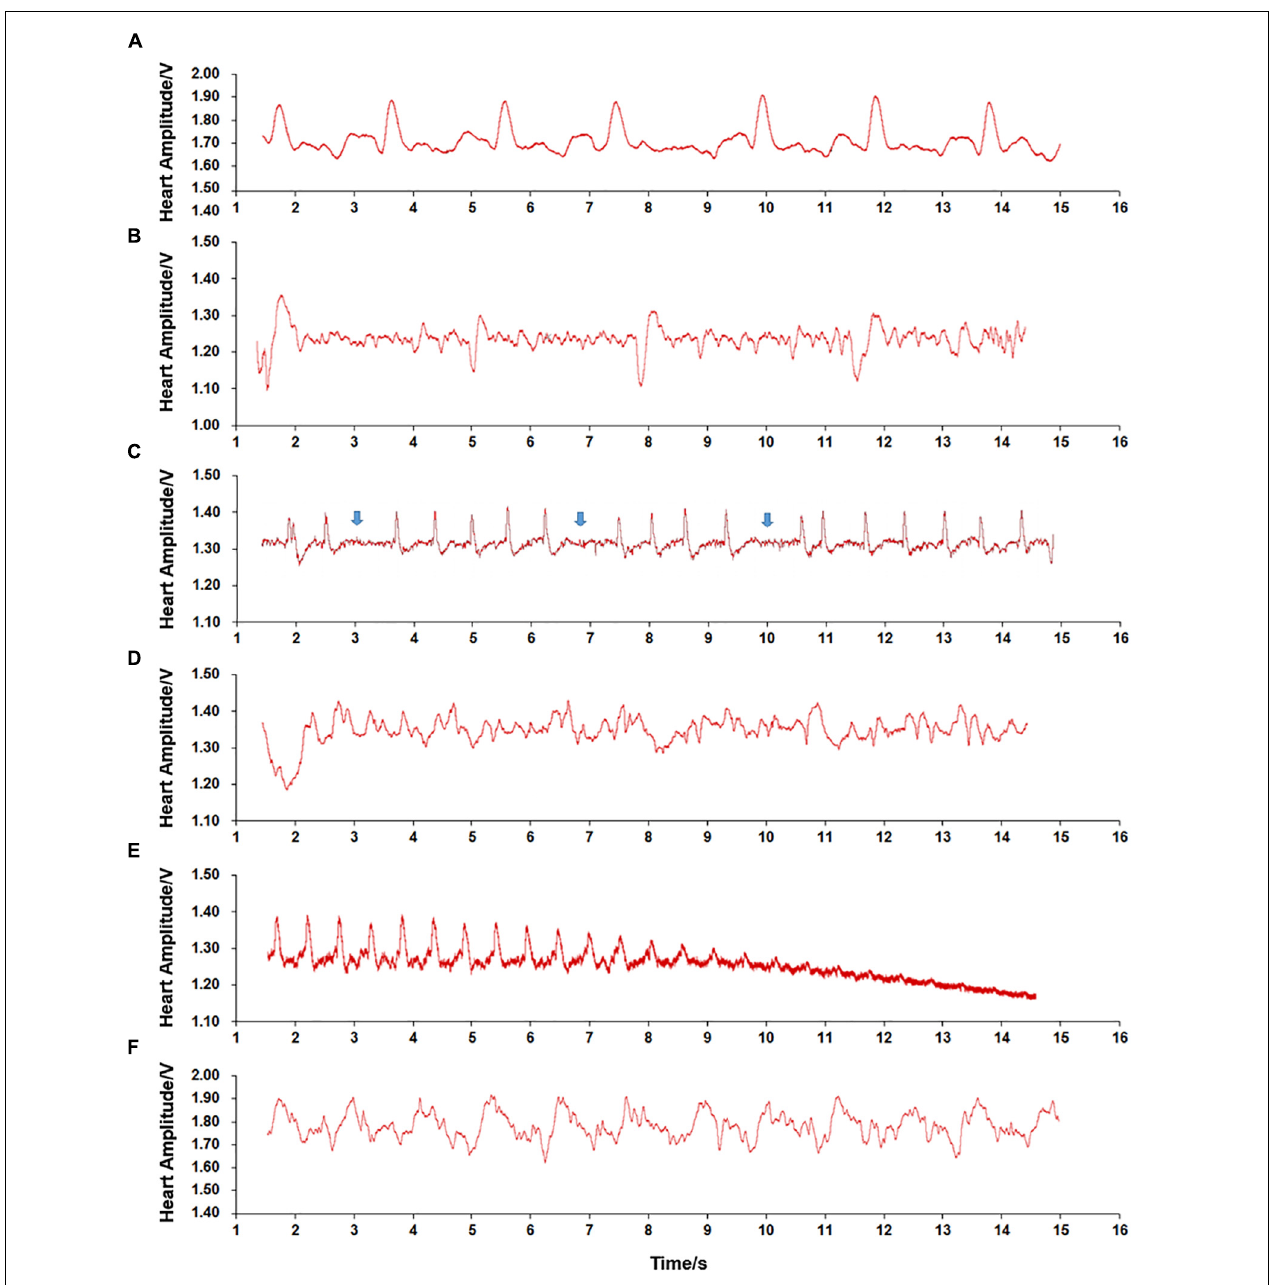
FIGURE 4 | Plethysmograms of cardiac performance recorded during temperature challenge. (A) Regular signal pattern recorded in scallops submerged in 15 ◦ C seawater. (B) Bradycardia recorded in scallops submerged at low temperature (5 ◦ C). (C) Temporary cardiac arrest recorded in scallops submerged at relatively high temperature (28 ◦ C). (D) Irregular signal pattern recorded in scallops submerged at high temperature (29 ◦ C). (E) Cardiac arrest recorded in scallops submerged at 32 ◦ C. (F) Regular signal pattern recorded in scallops returned to control temperature (15 ◦